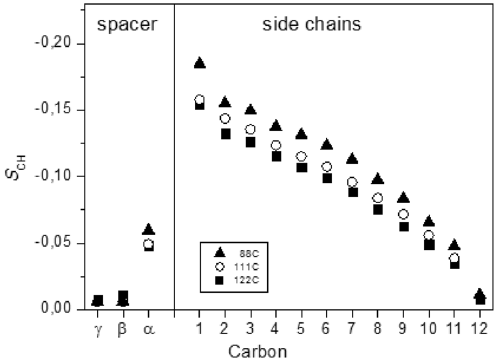
Figure 3. Local bond order parameters of the aliphatic carbons in the sample C 6 (C 12 im) 2 Br 2 in the smectic phase.